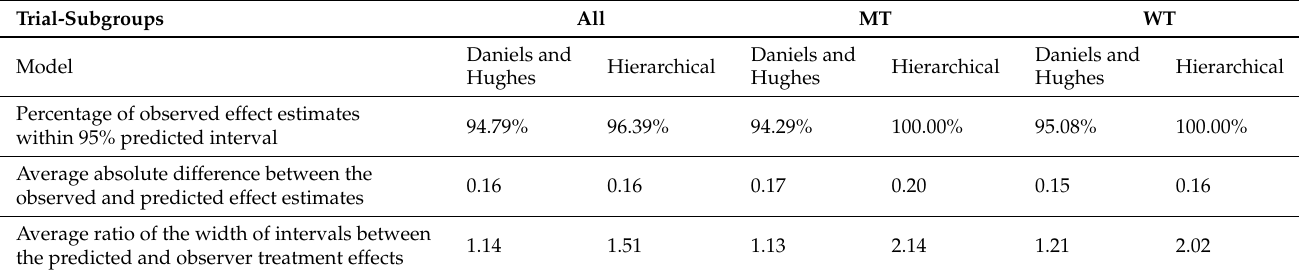
Table A1. Summary of cross validation results for all analyses for PFS as a surrogate for